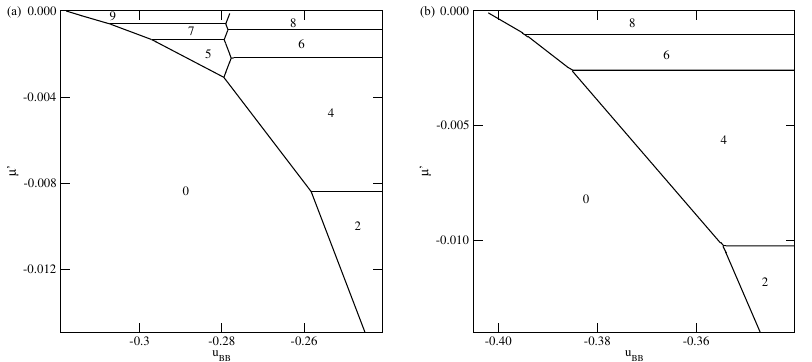
Figure 10. The ground state phase diagrams for the systems with V A = − 0.6 and V B = − 0.2 ( a panel) and with V A = − 0.6 and V B = − 0.3 ( b panel). The numbers mark the numbers of layers stable in different